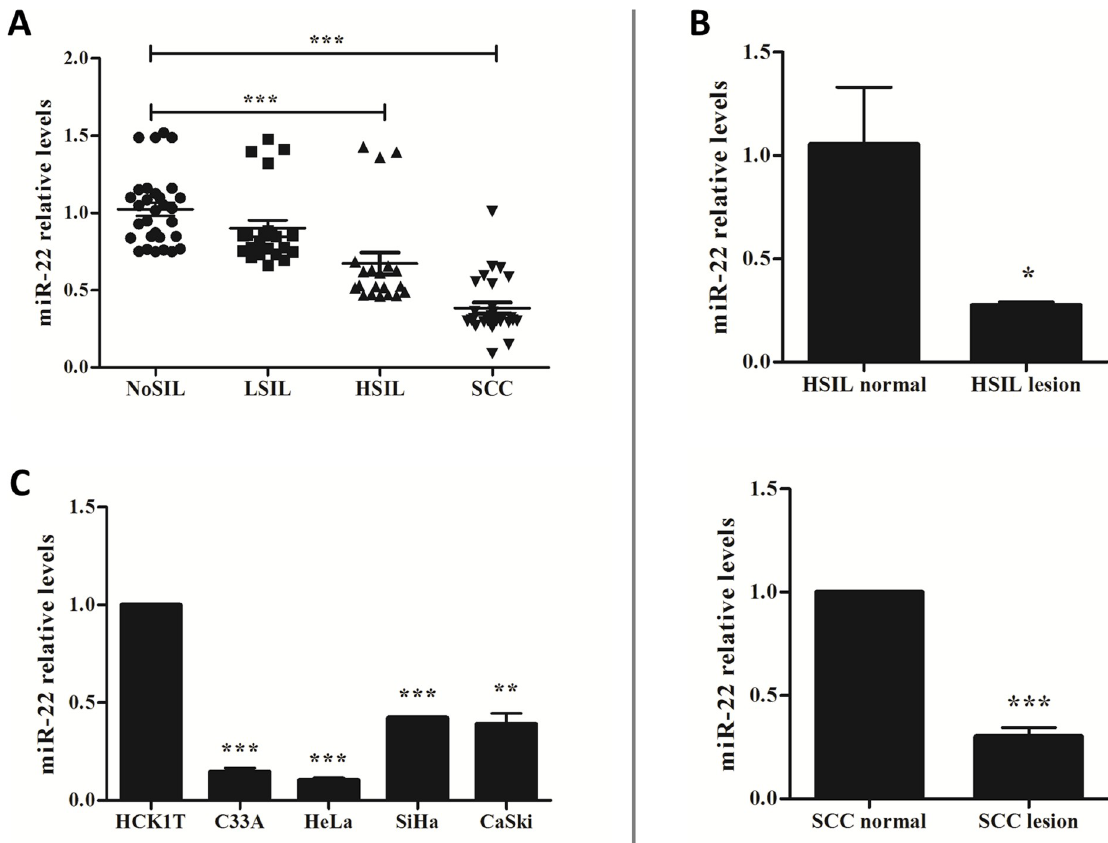
Fig 1. miR-22 was down-regulated in cervical cancer tissues and cell lines. A. The relative levels of miR-22 in the different grades of fresh-frozen cervical tissues. B. Comparison of miR-22 expression levels between lesion tissues and adjacent normal tissues in HSIL and SCC FFPE samples. C. The relative levels of miR-22 in four cervical cancer cell lines and one immortalized human cervical keratinocyte line (HCK1T). The levels of miR-22 were measured by qRT-PCR and normalized with U44 small nuclear RNA. � P < 0.05, �� P < 0.01, ��� P <